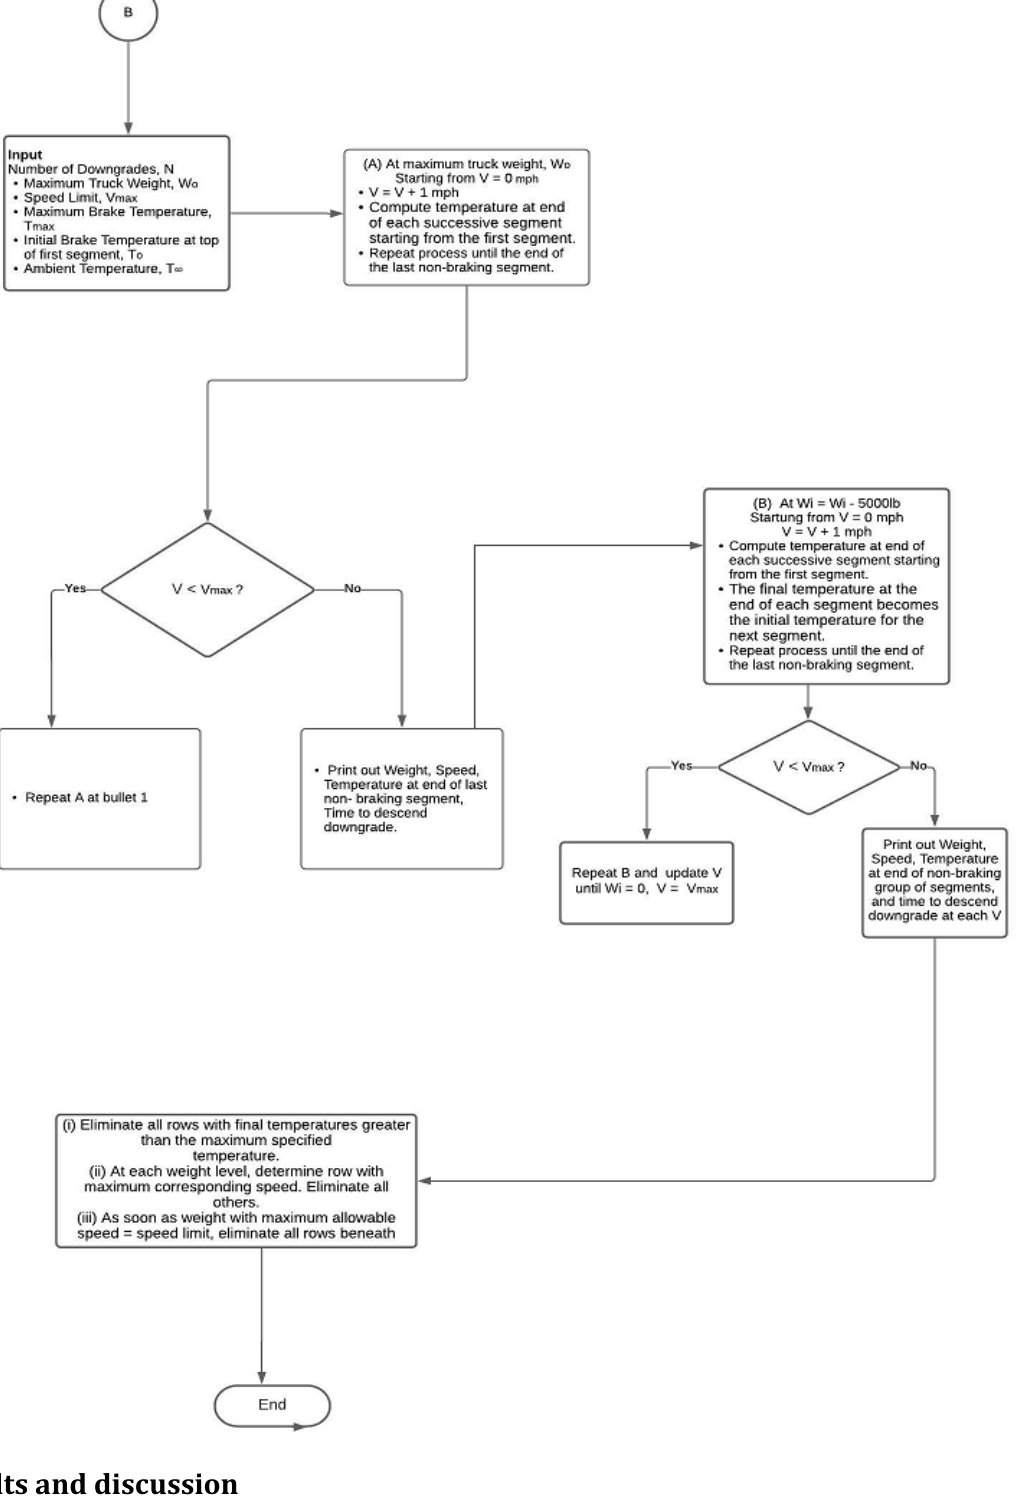
Figure 3: Process flow chart for a non-braking phase of separate downgrade